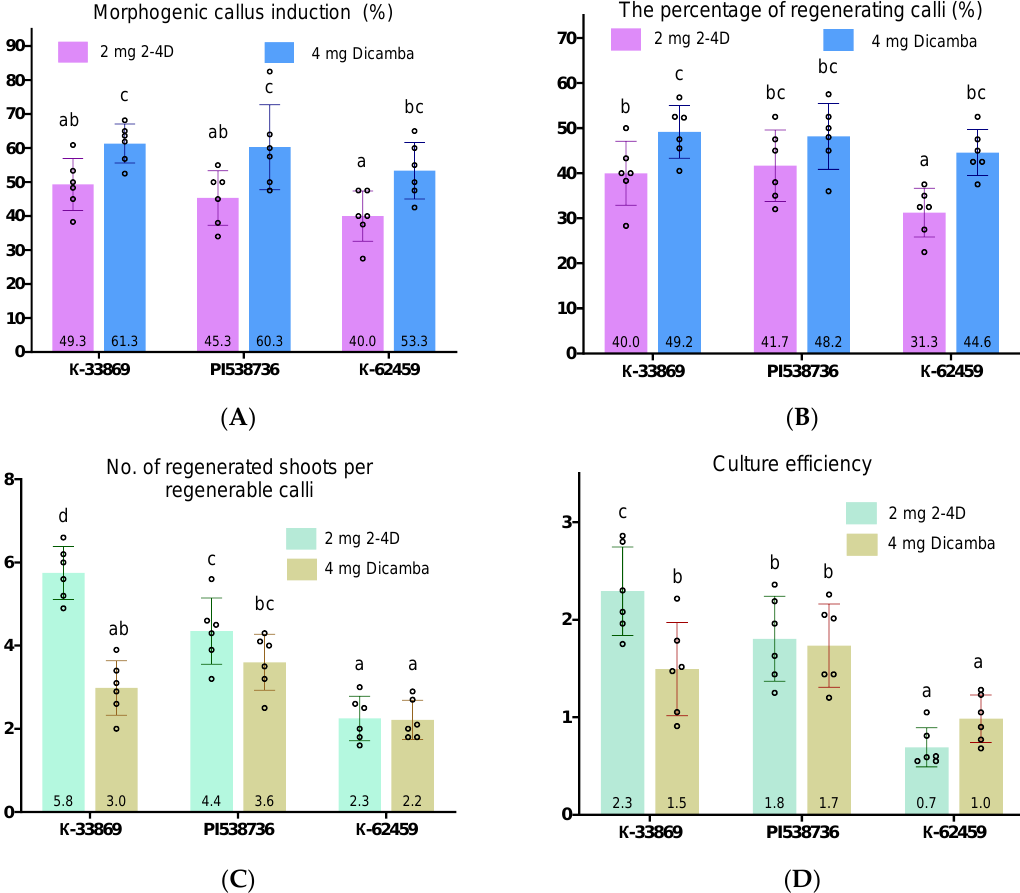
Figure 2. Morphogenic response of three winter accessions of Triticum urartu cultivated on two callus-induction media: the first was supplemented with 2 mg·L −1 2,4-D; the second was supplemented with 4 mg·L −1 2,4-Dicamba. ( A ) The percentage of explants that produced morphogenic calli (%); ( B ) the percentage of explants that produced regenerable calli (%); ( C ) number of plantlets regenerated from one regenerating calli (%); ( D ) tissue culture efficiency, calculated as the average number of plants regenerated per single isolated immature embryo. Data collected from two media were subjected to two-way ANOVA; means with the same letter in the column had no significant differences according to Duncan’s multiple range tests ( p < 0.05).